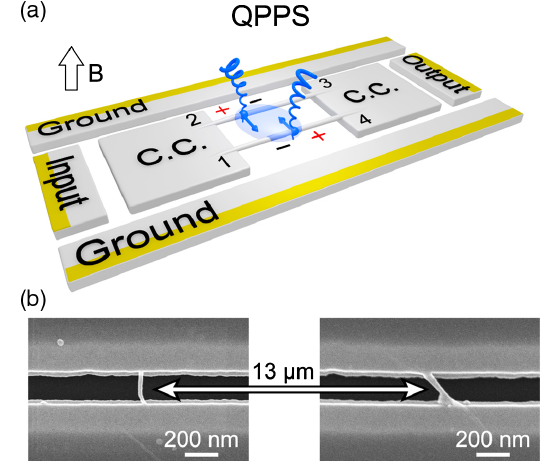
FIG. 1. Schematic representation of the samples (not to scale). (a) The superconducting coplanar resonator has two nanowires in the middle of the center conductor, which are suspended over a trench in the substrate (see Ref. [27], SM-1). MoGe film is shown in gray; regions where it is removed are shown in white. The superconducting loop is threaded by an external magnetic field B . Yellow stripes depict gold coating. QPPS is shown as a pair of fluxoids simultaneously crossing both nanowires. Each fluxoid changes the phase accumulated on the loop by 2 π and generates =dt Þ = 2 e . Plus and minus voltage on each wire, V ¼ ℏ ð d ϕ wire signs indicate the quadrupole charge distribution during QPPS. (b) Scanning electron microscope images of the nanowires in sample A. The spacing between nanowires is 13 μ